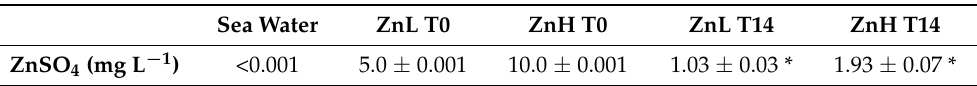
Table 2. Zinc content in seawater used to cultivate C. racemosa . Asterisks (*) indicate significant differences between treatments comparing T14 vs. T0 ( p ≤ 0.05).